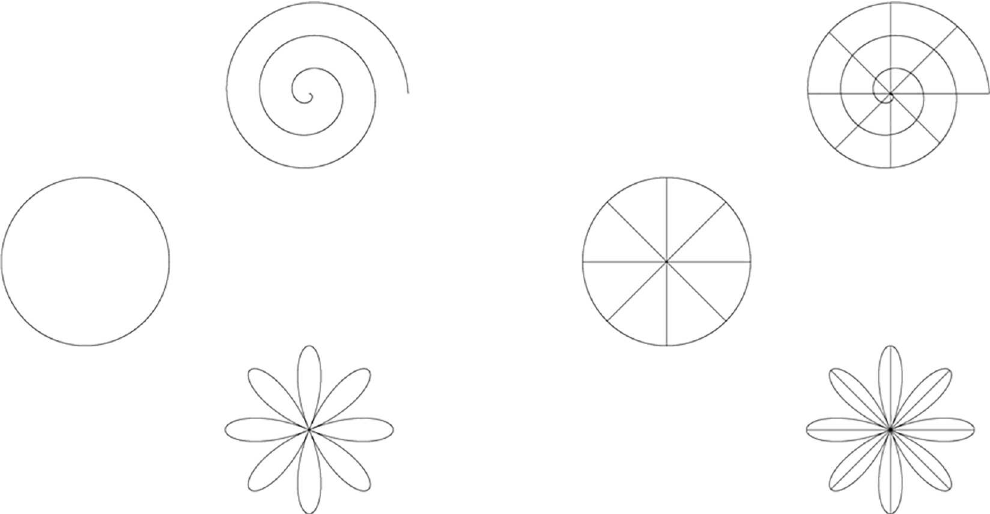
Fig 12. Multiple-camera calibration